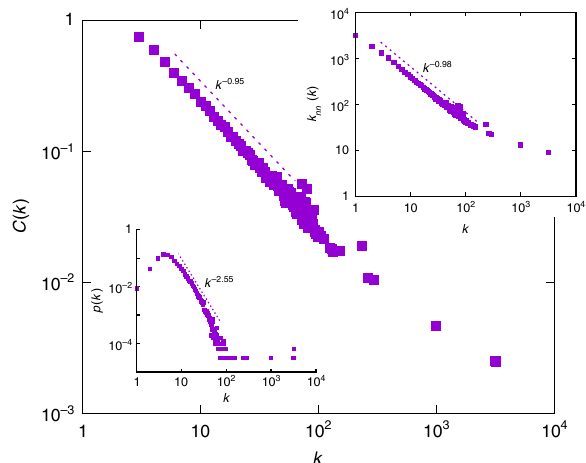
Fig. 6 Protein interaction networks. Statistical comparison with protein interaction networks: clustering coef fi cient C ( k ) (main plot), neighbours mean degree k nn ( k ) (top inset) and probability distribution p ( k ) (bottom T Þ ( T = 0.5, α = 1.05). We include inset) along the critical transition line α t c ð a power-law fi t of the tails, the exponents are: μ M = 2.55(1), v M = 0.98(1) and θ M = − 0.95(2), respectively, for p ( k ), C ( k ) and k nn ( k ). Data points are averaged over 100